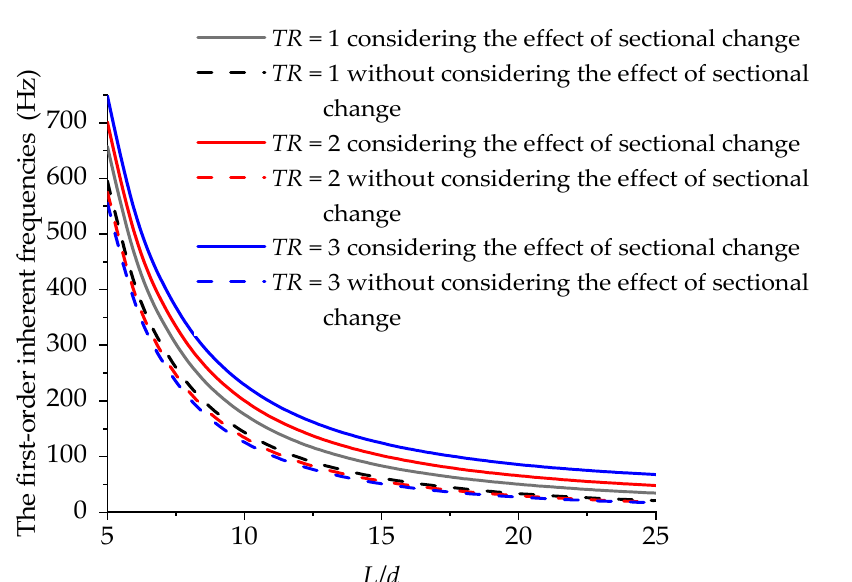
Figure 10. Schematic diagram of composite toolholder model ( 0 Table 2. Effect of the change of the length-to-diameter ratio on the first-order inherent frequency of the boring bar under different TR values ( ψ = 0 ). Taper Ratio of the Boring Bar Length-to- Diameter Ratio